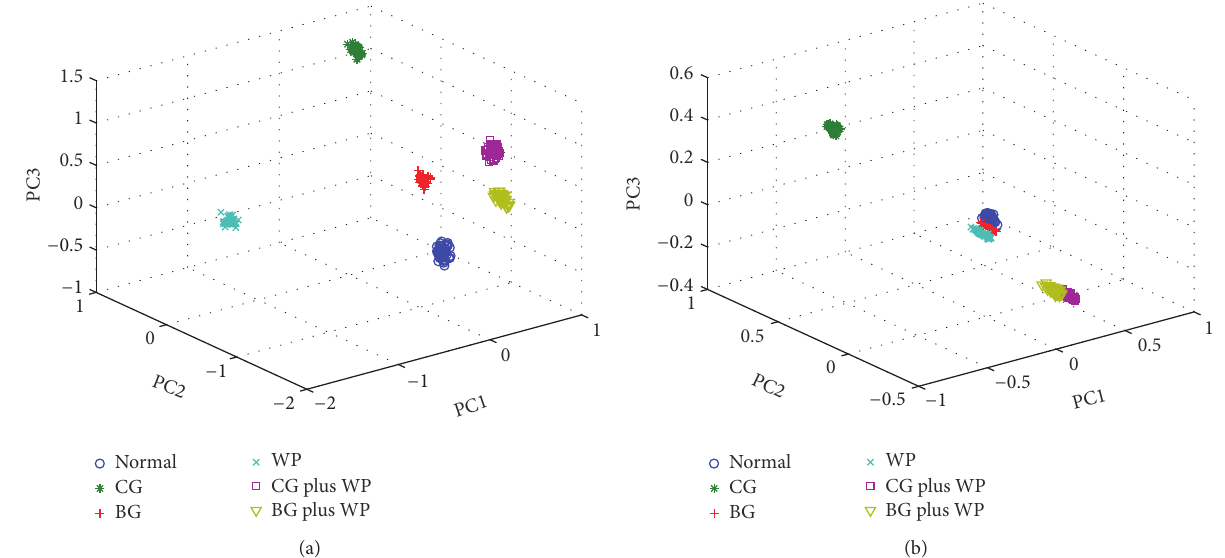
Figure 5: Scatter plots of the vector-formed dimension reduction result based on different algorithms for the training sample set: (a) SSTLPP- AMDM and (b)